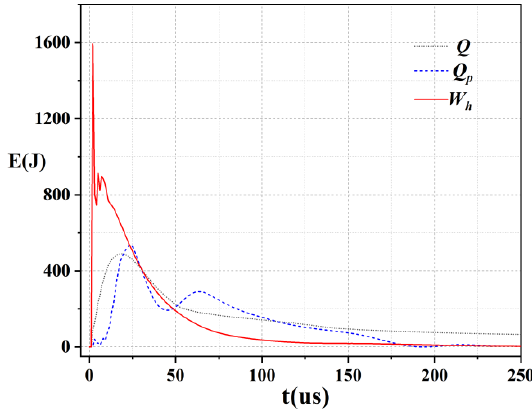
Figure 7. Energy distribution curve (70 kV).